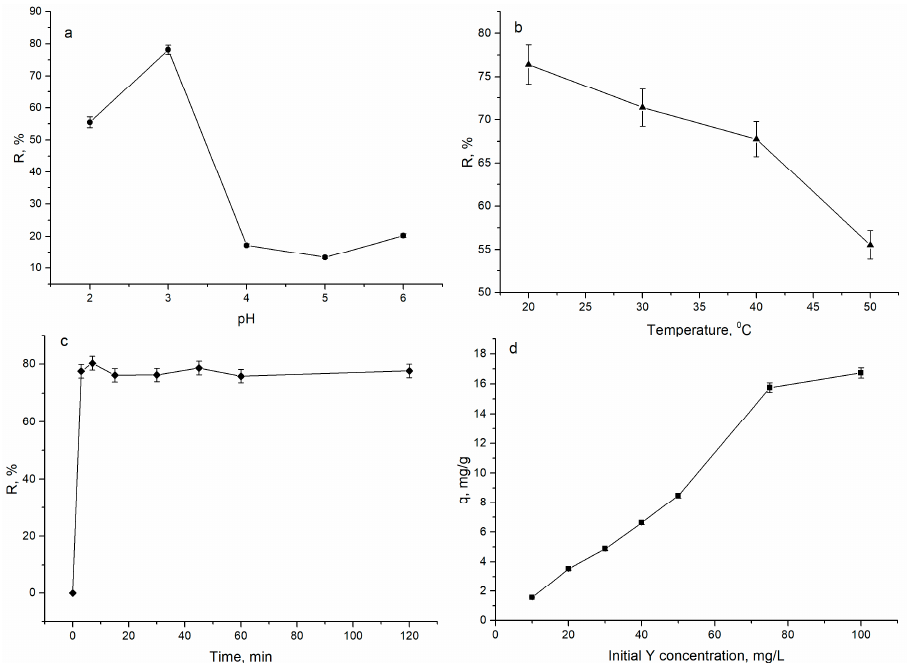
Figure 1. Influence of adsorption parameters ( a ) pH; ( b ) temperature, ( c ) time, and ( d ) Y(III) concentration on the biosorption capacity of spirulina biomass.